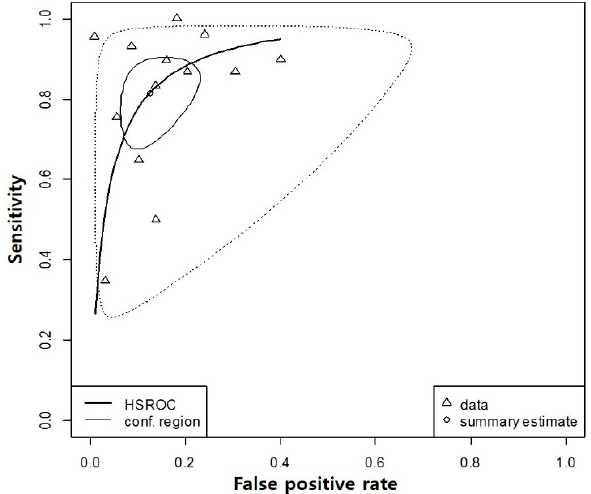
Figure 3. Hierarchical summary receiver operating characteristics curve of the 4AT. HSROC, Hierarchical summary receiver operating characteristics curve; 4AT, 4 ‘A’s Test.